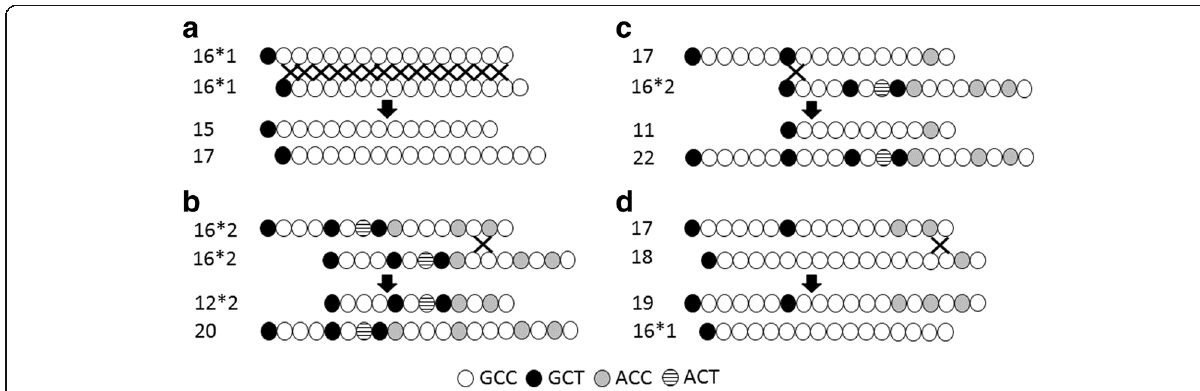
Fig. 2 Derivation of GSTP1 5 ′ UTR microsatellite alleles by unequal recombination between identical ( a , b ) and distinct ( c , d ) repeat sequences. Possible point of an exchange is indicated by an ‘ X